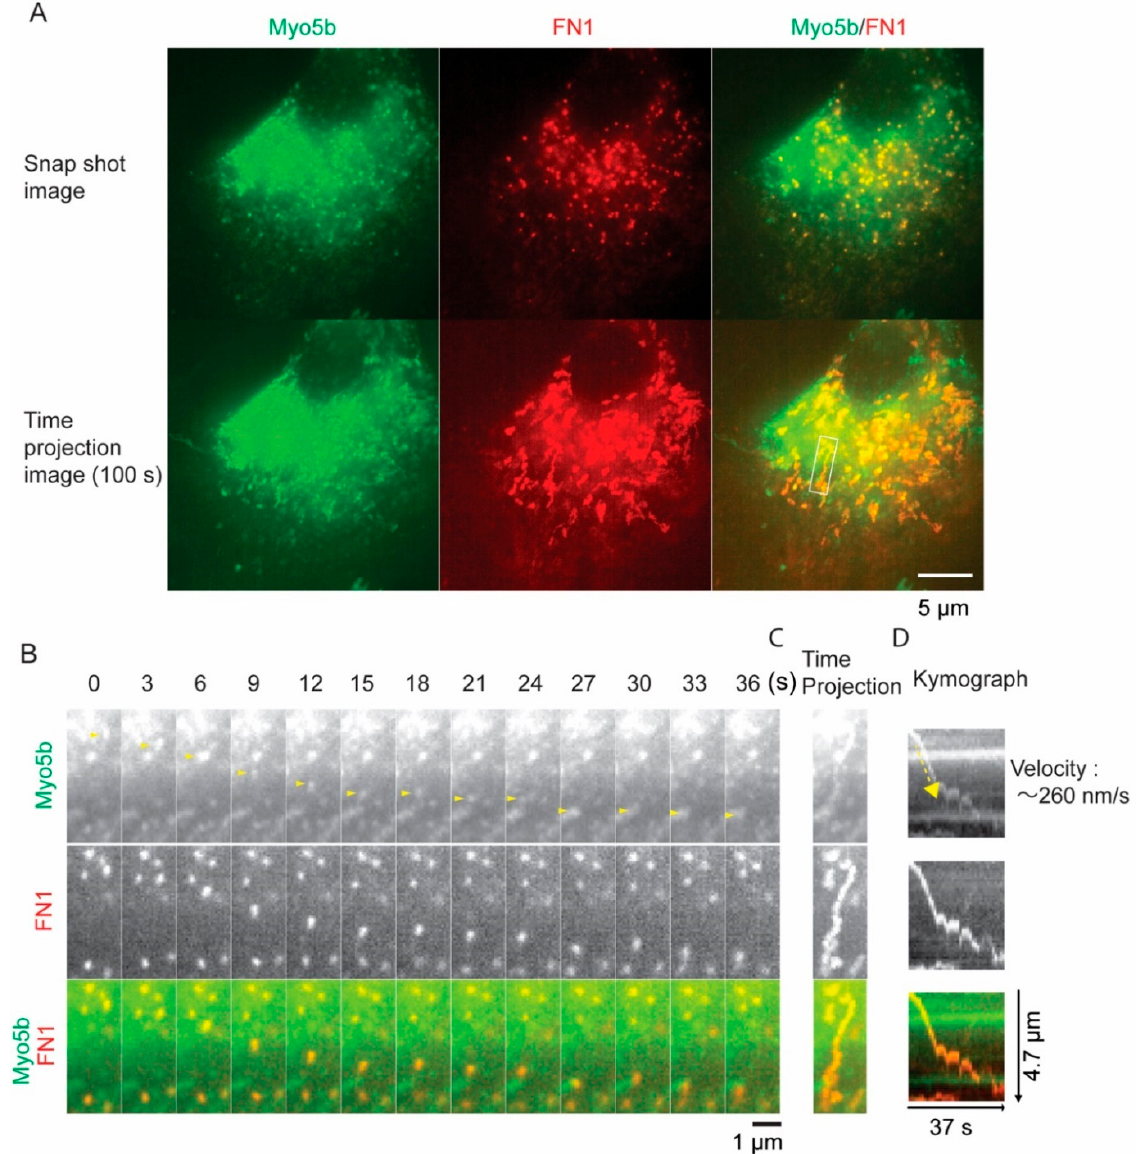
Figure 13. Direct visualization of the movement of Myo5b and FN1 in live HPMCs. ( A ) Representative first snap-shot image (top panel) and time projection images (bottom panel) (100 s; 100 frames) of GFP-Myo5b and mCherry-FN1(EDA) in live HPMC. Scale bar, 5 μ m. Continuous movements are observed in the bottom panels. ( B ) Magnified time-lapse montages of the fluorescent proteins in white box in A. top, GFP-Myo5b; middle, mCherry-FN1 (EDA); bottom, merged images. Time (sec) is shown in the top. Scale bars, 1 μ m. ( C ) Time projection image of ( B ). ( D ) kymograph showing the co-movement of GFP- Myo5b and mCherry-FN1 (EDA). The kymograph was generated based on the tracking line connecting the center of the fluorescent spot of GFP- Myo5b shown in yellow arrowheads in B. The velocity of the movement of GFP- Myo5b (yellow dotted line and arrow) is about 260 nm/s. Scale bar, 1 μ m. HPMCs were stimulated with TGF- β , and then GFP- Myo5b and mCherry-FN1(EDA) were expressed using the corresponding viral expression vectors. The cells were imaged using DeltaVision OMX (GE Healthcare Life Sciences) at 10 h and 16 h after transduction for GFP-Myo5b and mCherry-FN1(EDA), respectively. Representative movie of n = 9 cells.